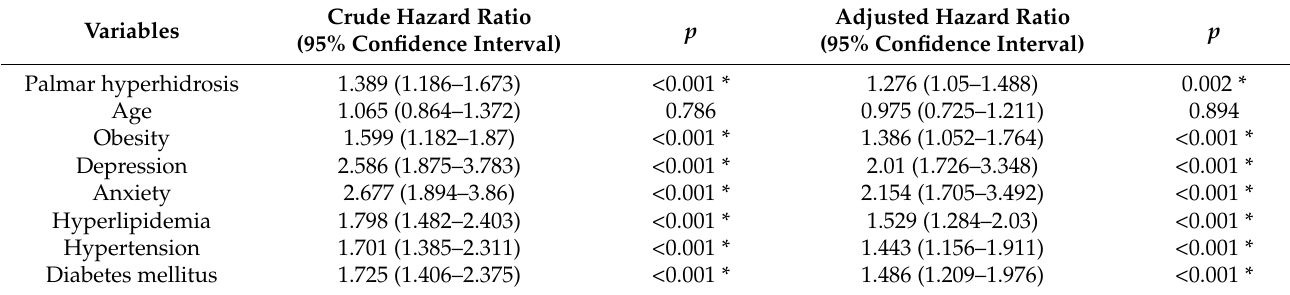
Table 2. Factors of premenstrual